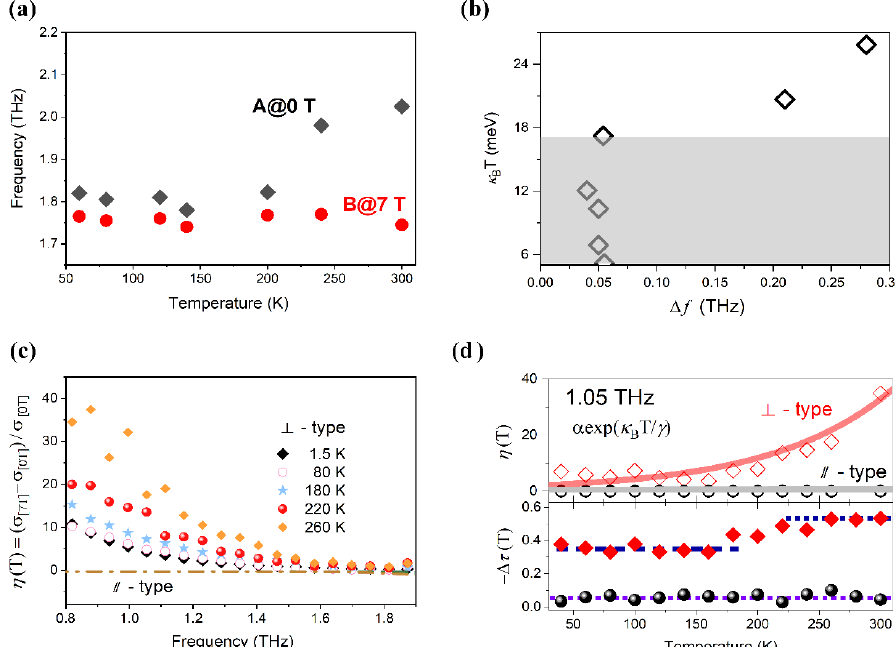
Figure 5. The analysis of THz measurements of 40 nm Mn 3+0.53 Sn samples. ( a ) The temperature dependence of the intersected points A and B. ( b ) The relationship between k B T and ∆ f (the frequency difference between A and B points). ( c ) The ratio η (T) = [Re σ (7 T) − Re σ (0 T)]/Re σ (0 T) in 0.8–1.9 THz range at different temperatures for // - and ⊥ -type samples. ( d ) Top: η (T) at 1.05 THz for // - and ⊥ -type samples. The result from an empirical formula, η ( T ) = α e k B T / γ , is drawn for fitting to the experimental data, where α and γ are fitting parameters; bottom: the temperature dependence of magnetic-field-induced THz transmittance difference − ∆ τ at 1.05 THz for // - and ⊥ -type samples. Here, ∆ τ = τ [7 T] − τ [0